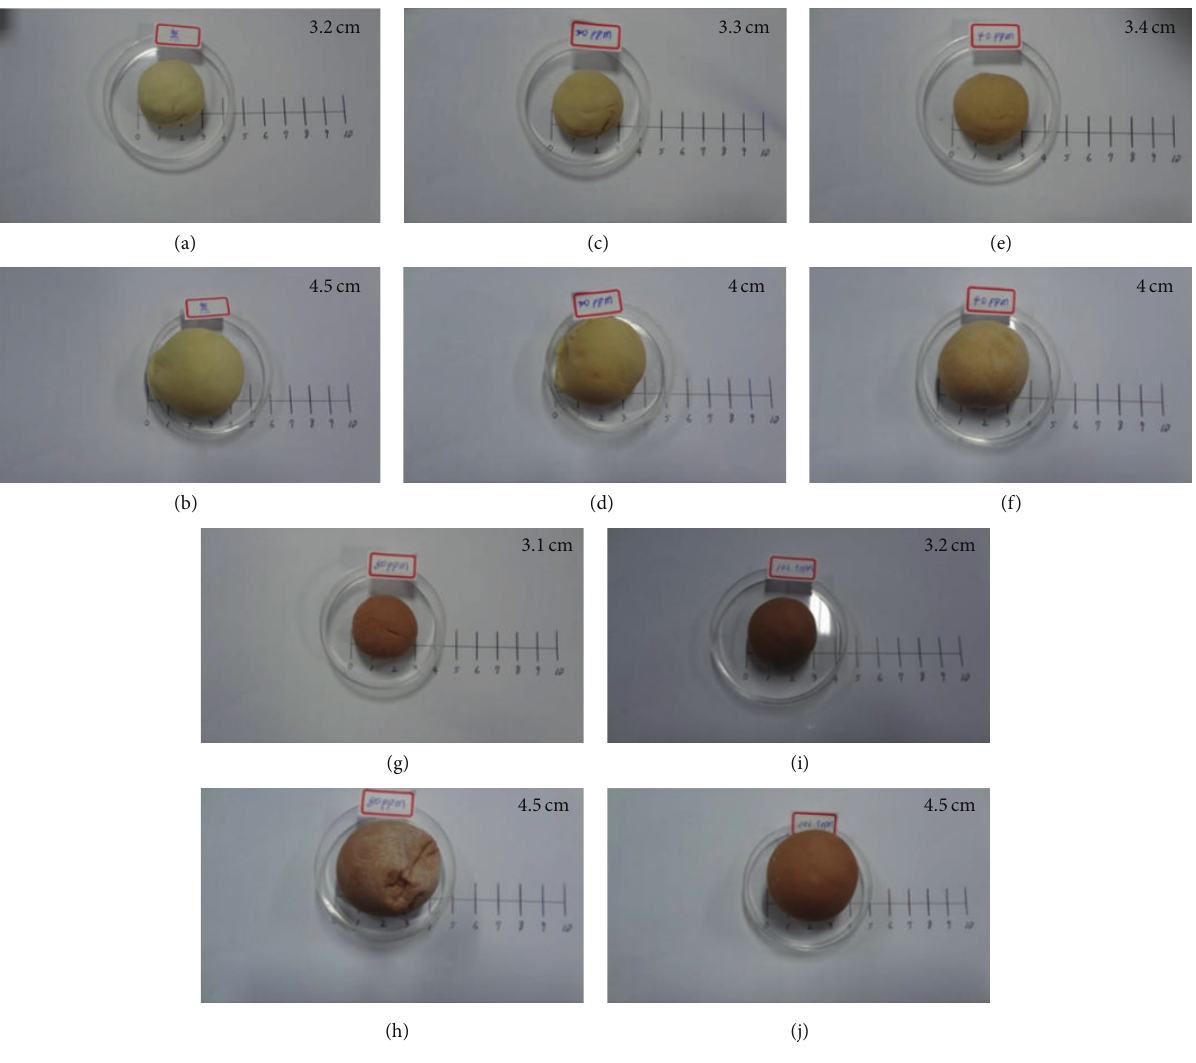
Figure 7: Experiment on antibioactivity of nanosilver for yeast.